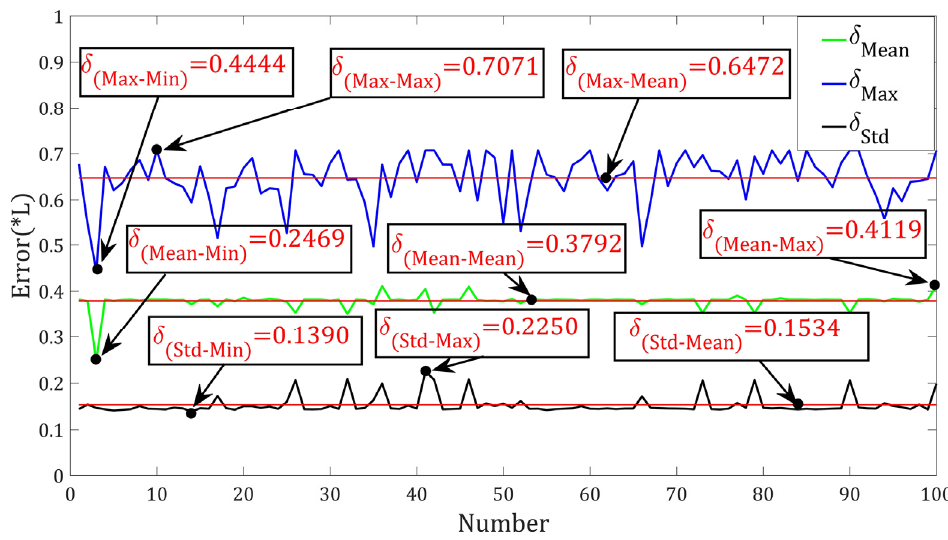
Figure 9. The error